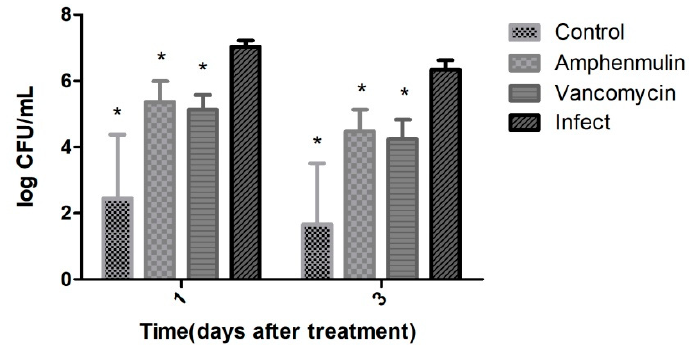
Figure 6. Wound bacterial burden at one and three days after treatment. * 0.01 < p < 0.05 vs Infect group.